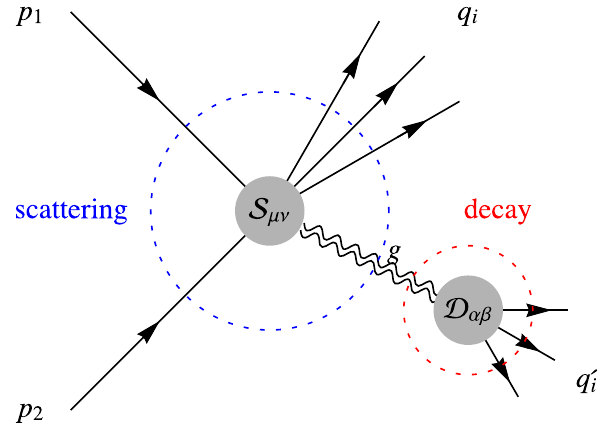
Fig. 2 A generic process among matter particles mediated by one gravi-ghost, denoted as a double